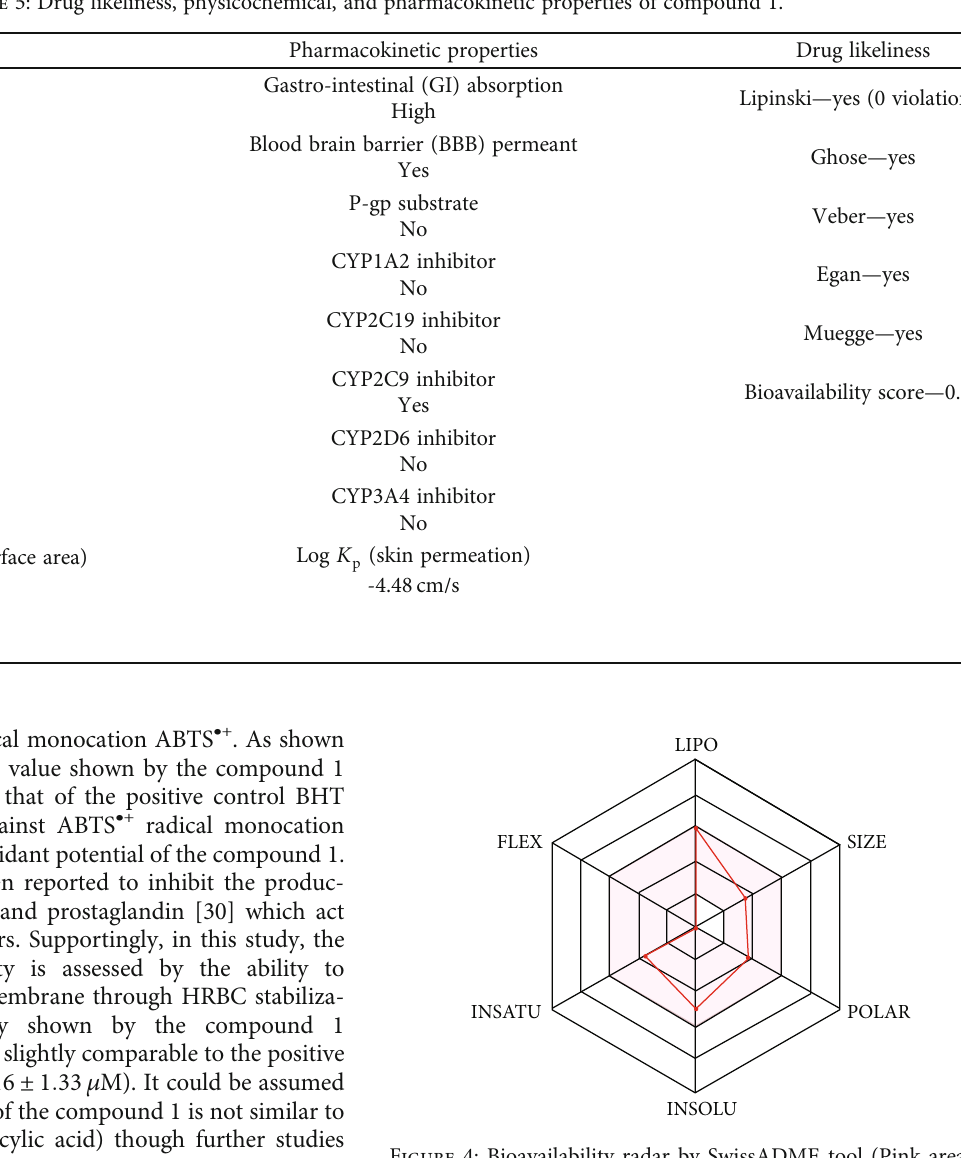
Table 5: Drug likeliness, physicochemical, and pharmacokinetic properties of compound 1.